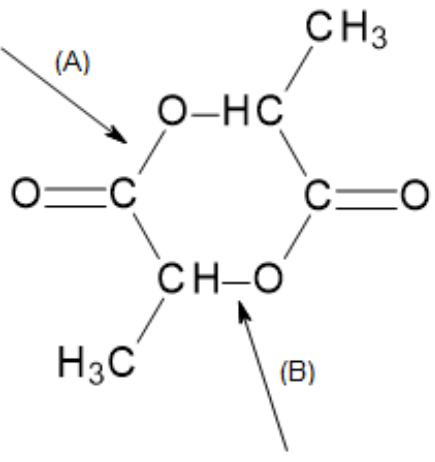
Figure 9. Possible positions of breaking lactide ring [5].